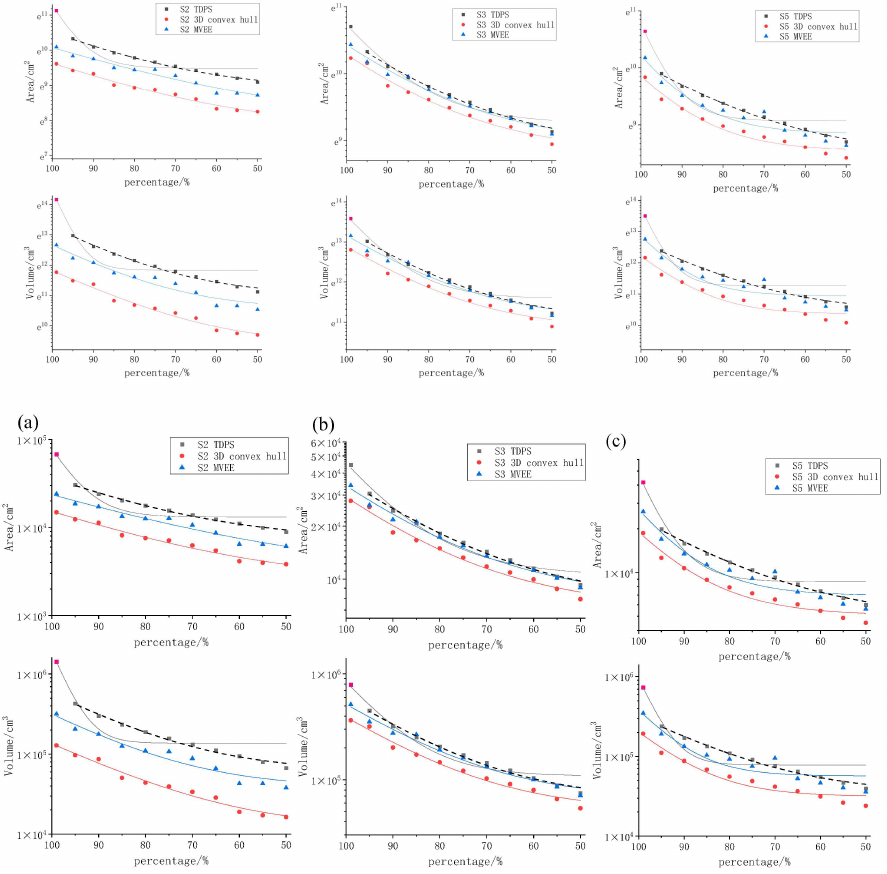
Figure 8. Fitting results of area and volume. ( a ) Fitting results of specimen S2. ( b ) Fitting results of specimen S3. ( c ) Fitting results of specimen S5. The black dashes are the fitting results after masking the maximum